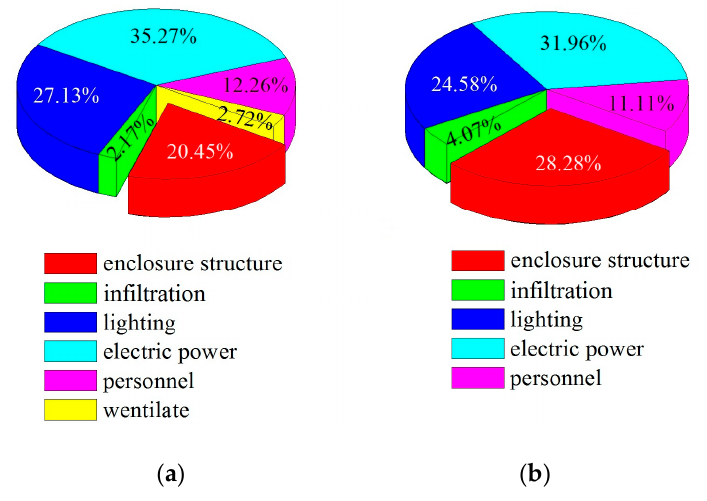
Figure 12. The energy demand percentages for (a) cooling load and (b) heating load.